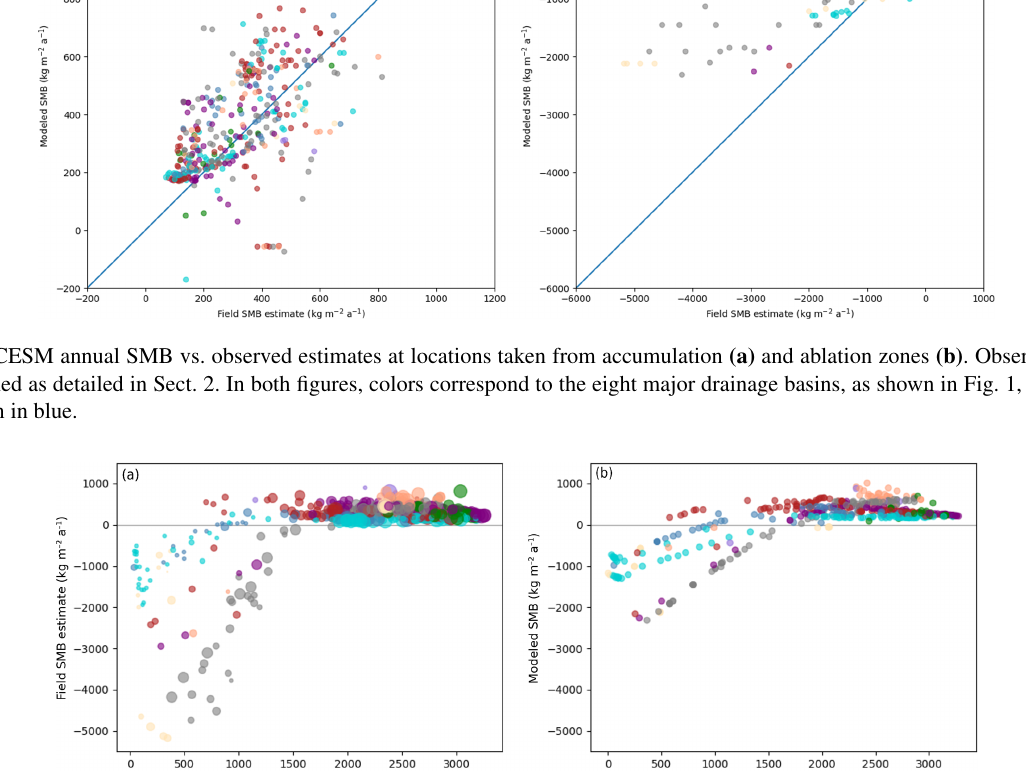
bias has a latitudinal gradient; SMB is overestimated